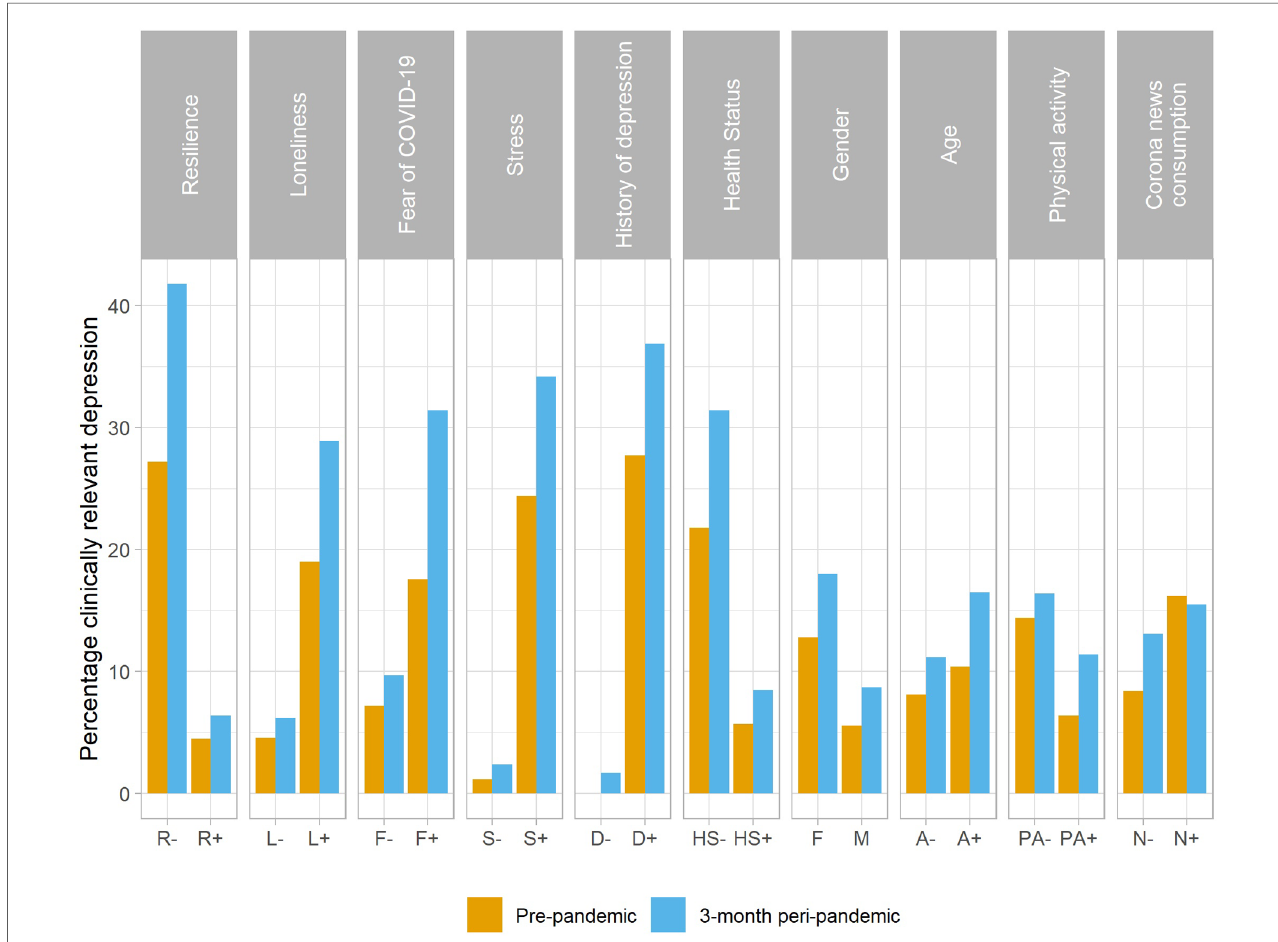
FIGURE 4 Prevalence (in %) of clinically relevant depression at pre- and 3-month peri-pandemic timepoints for dichotomized variables of the path model of depression severity. Abbreviations and subgrouping criteria are given in Table 2